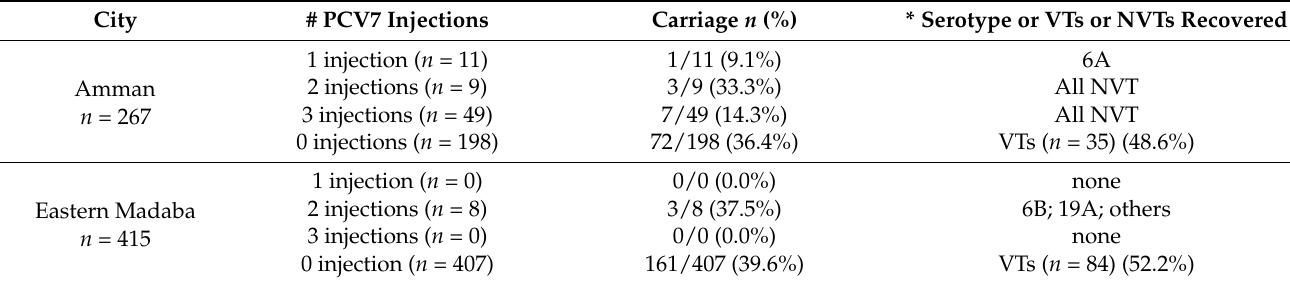
Table 2. Carriers from Amman and East Madaba with a history of PCV7 injections.